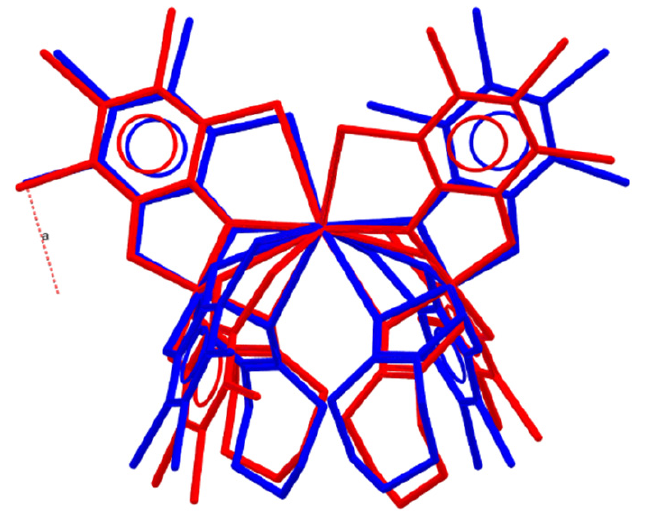
Figure 3. {K[Si L Cat x 2 ] 2 } − anions represented with overlayed K and Si atoms in solid 3a and 3b . One of the most noticeable structural features of the crystal structure was the packing motifs formed by the R 2 CHR 3 NCOSi(cat X ) anions. In previously studied structures, the R 1 CHR 2 NCOSi(Cat) and N[cyc] 2+ cations formed chains via N − H . . . O bonds. Besides, non-coordinated catechol was also found to be H–bonded to anions. In solid 1 − 7, the cation (NH 2 [cyc] 2 + ) formed two N − H . . . O bonds with catecholate anions or solvent molecules. In crystals of 1 − 3a and 5, water molecules or catechol co-formers also took part in H– bonding. However, neither acetamide nor caprolactam took part in H–bonding in all these compounds. Note, that H–bonds weaken the Si − O Cat bond involved in the H–bonding, as was demonstrated by the DFT calculations [19]. This effect can be demonstrated in the example of solvent-free salt 7 . The Si1 − O2 and Si1 − O3 bonds involved in N–H . .